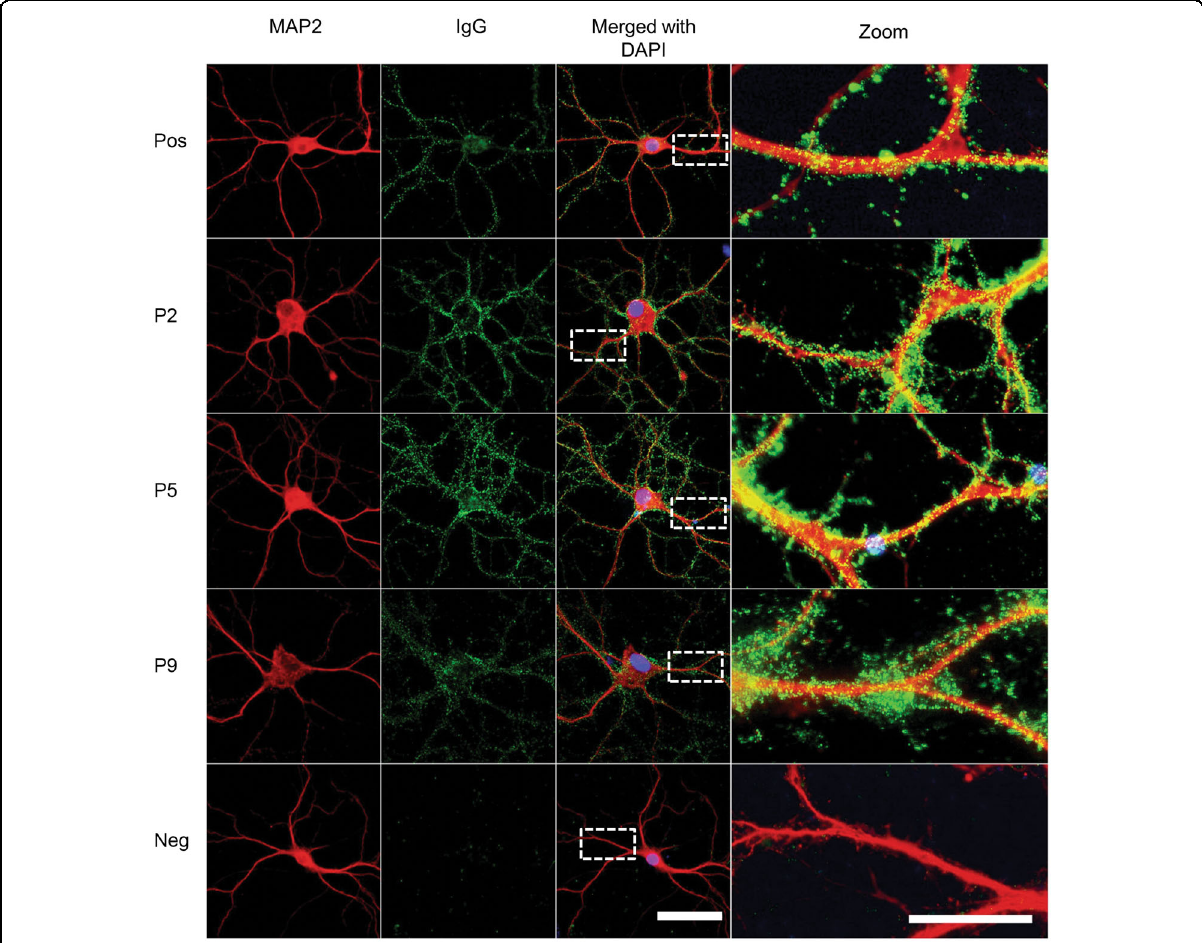
Fig. 2 Immuno fl uorescence staining on primary hippocampal live neurons of plasma samples from selected individuals. Neurons were stained with anti-MAP2 (red), autoantibodies were stained with anti-human IgG (green) and nuclei were stained with DAPI (blue). Serum from an encephalitis patient with NMDAR autoantibodies was used as a positive control ( “ Pos ” ), plasma from a healthy individual was used a negative control ( “ Neg ” ). Plasma samples from Case 2, Case 5, and Case 9 showed clear immunoreactivity to live neurons. Scale bar = 50 µm. Regions in white boxes are shown at higher magni fi cation on the right panels; these show a speckled human IgG staining along the dendrite. Scale bar = 20